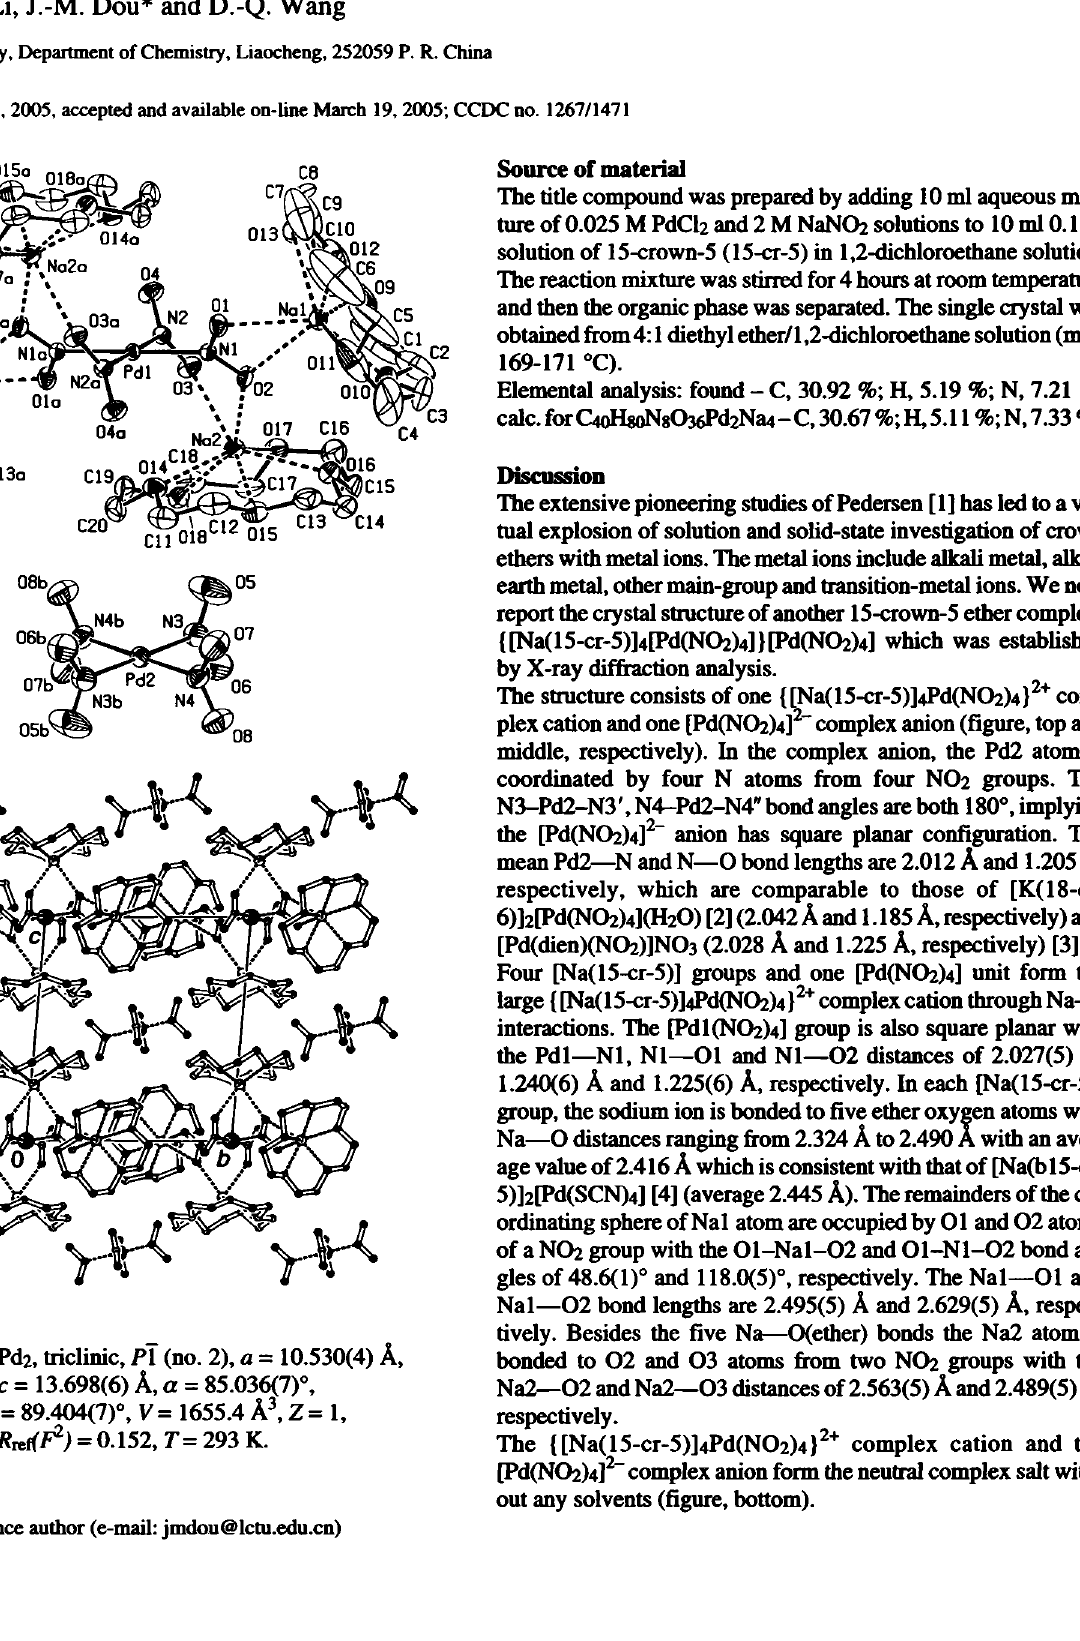
C4oH oN8Na4036Pd2, triclinic, PI (no. 2), a = 10.530(4) 8